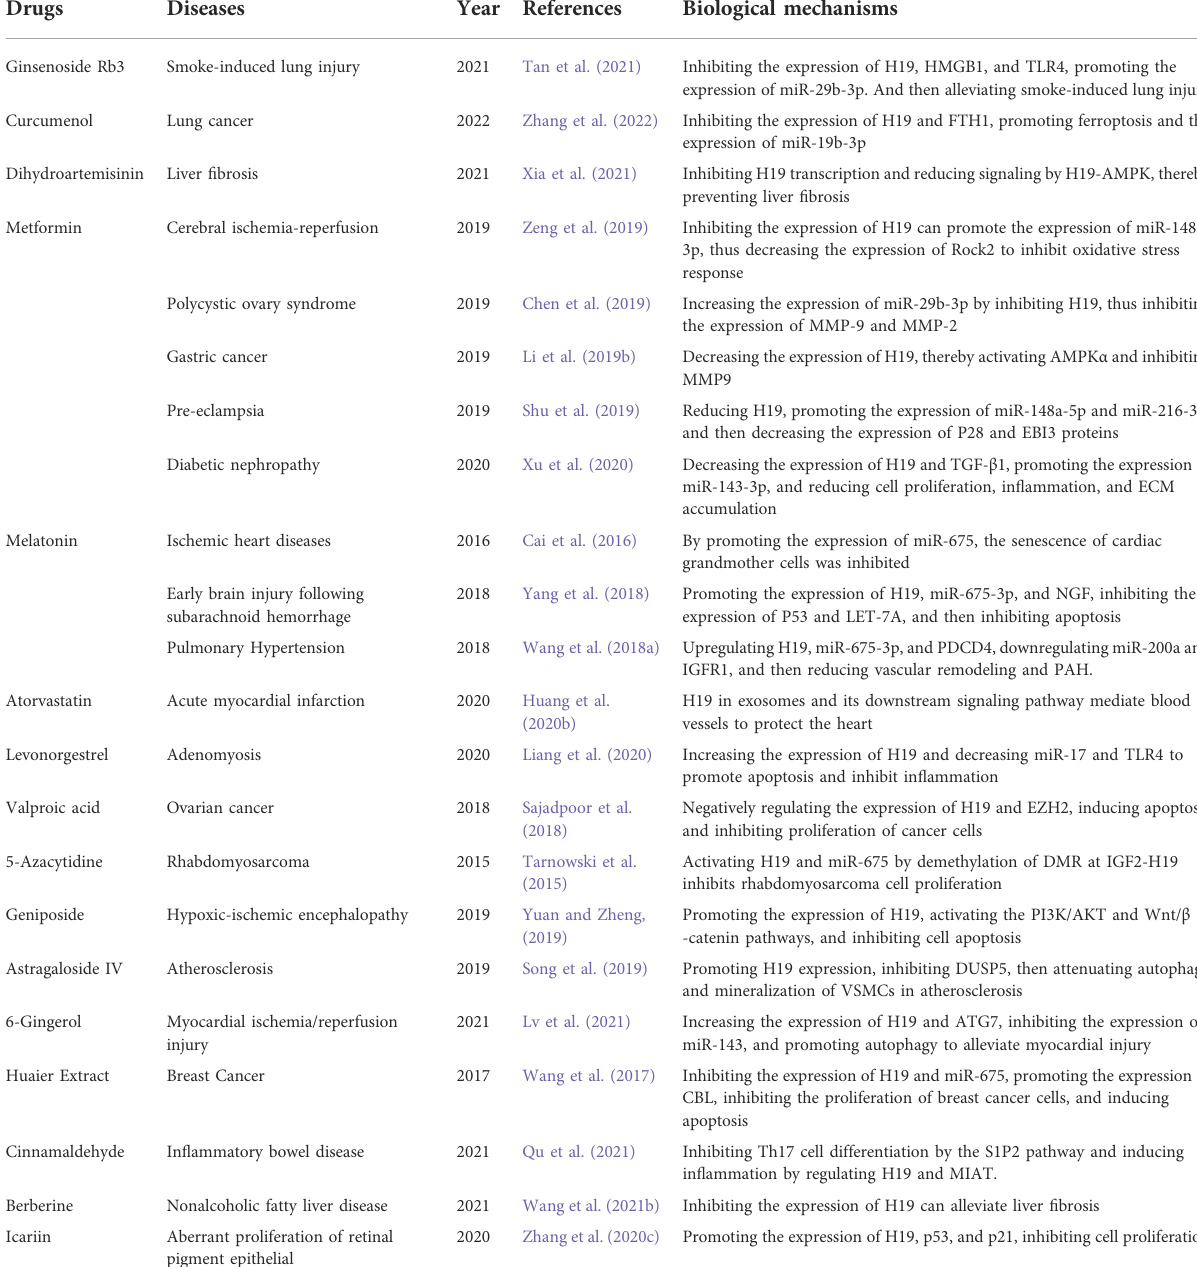
TABLE 2 The drugs targeting